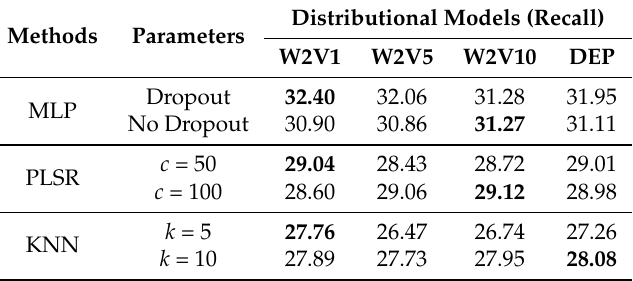
Table 5. The percentage average recalls for all